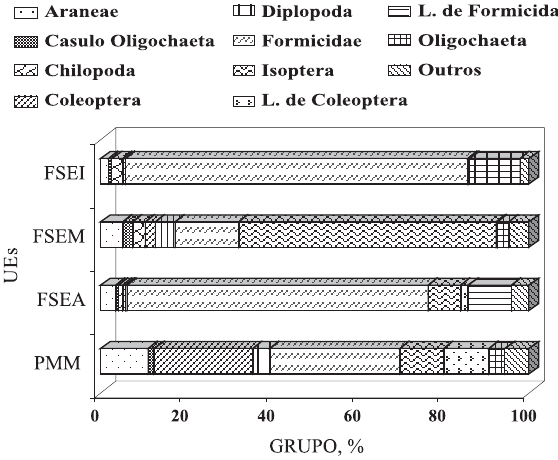
Figura 6. Distribuição vertical de densidade da